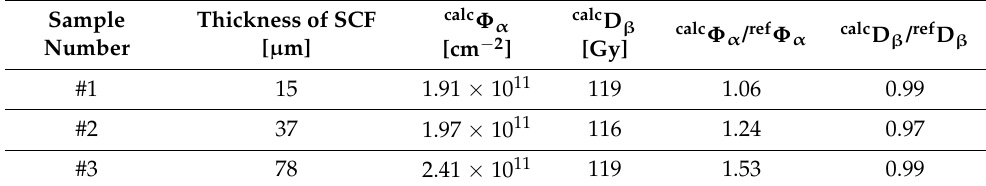
Table 4. Calculations of the contributions of alpha particles and beta radiation to the